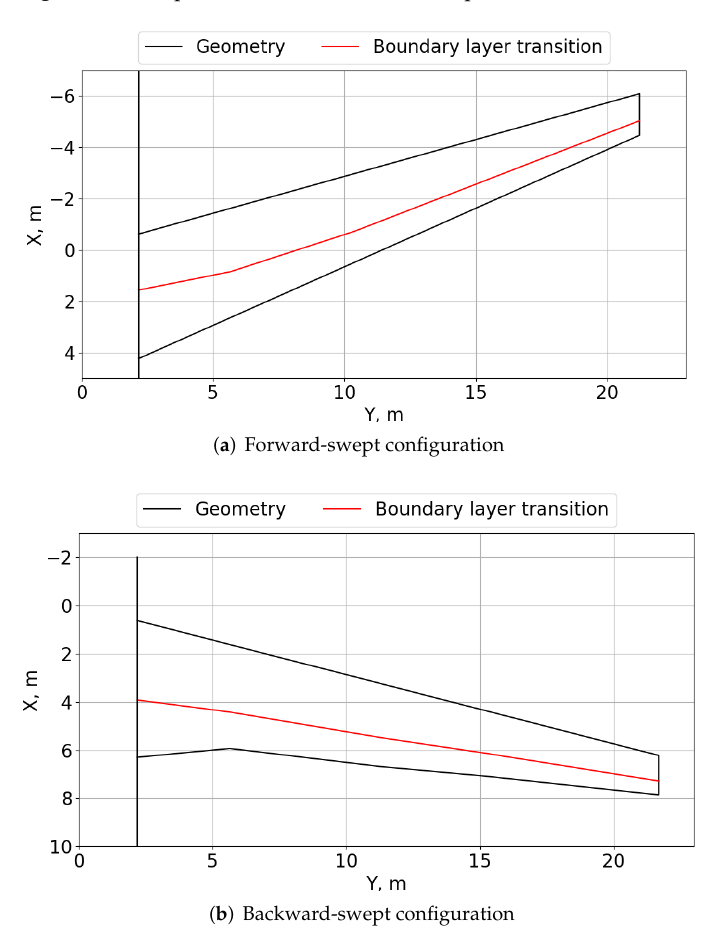
Figure 15. Boundary layer transition profile for designed